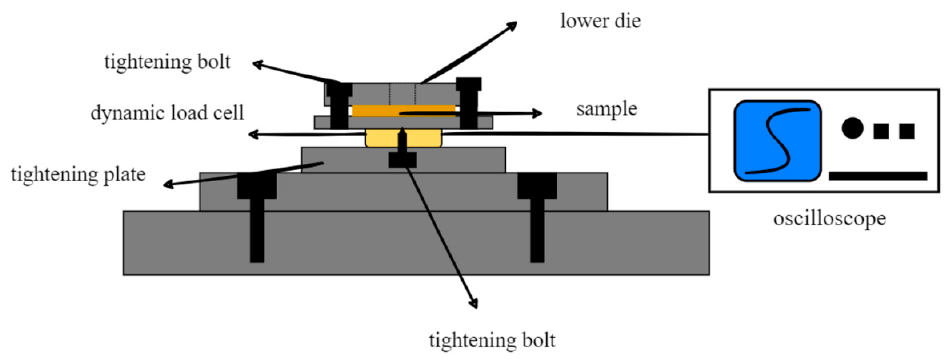
Figure 4. Dynamic force test system.